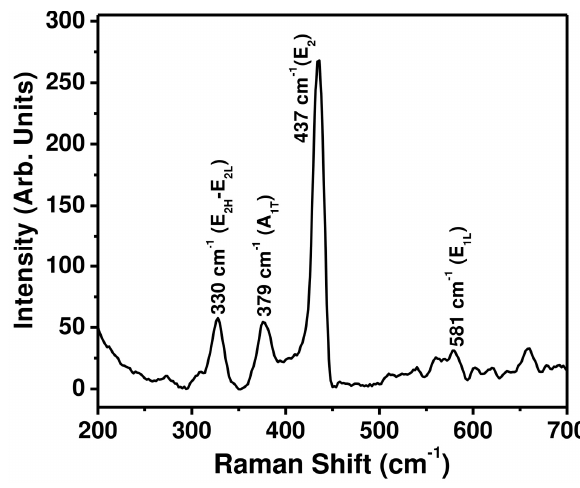
Figure 4. Typical Raman-scattering spectrum of the as-synthesized ZnO